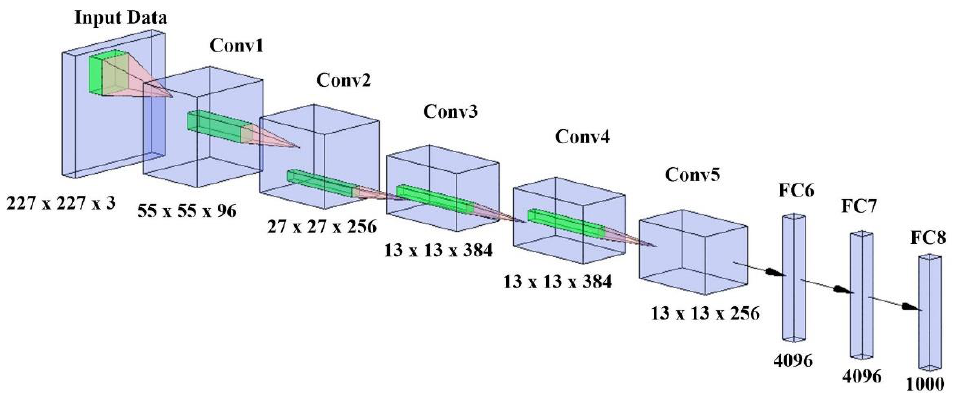
Figure 10. AlexNet architecture.